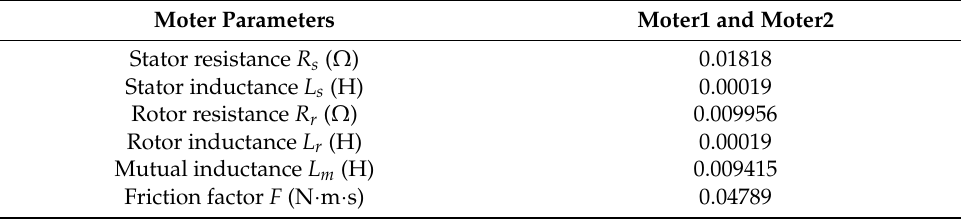
Table 2. Parameters of the motors.